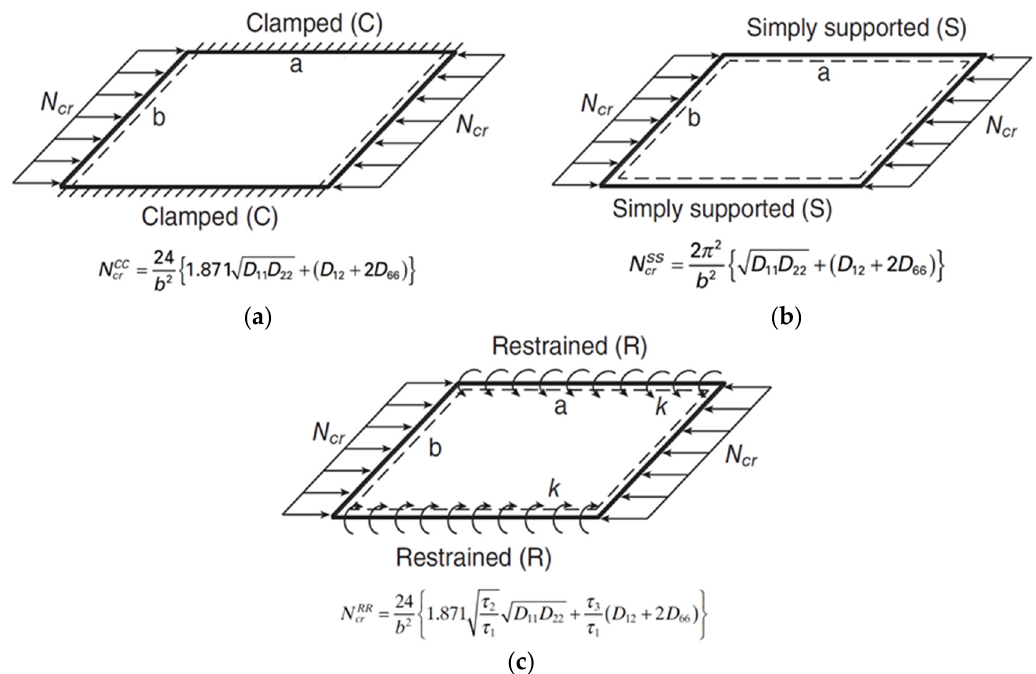
Figure 4. FRP plates of box profile with various unloaded edge conditions: ( a ) clamped, ( b ) simply supported, and ( c ) elastic restrain (modified from [121]).